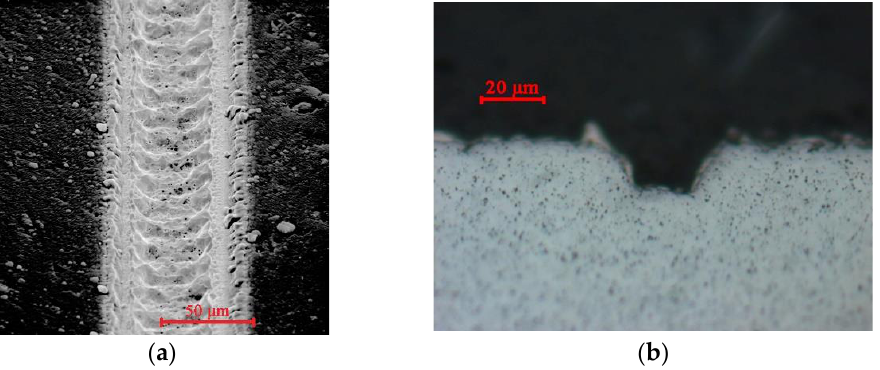
Figure 1. View of grooves on the hard alloy surface when treated with a nanosecond laser: ( a ) the top view; ( b ) the groove cross-section.